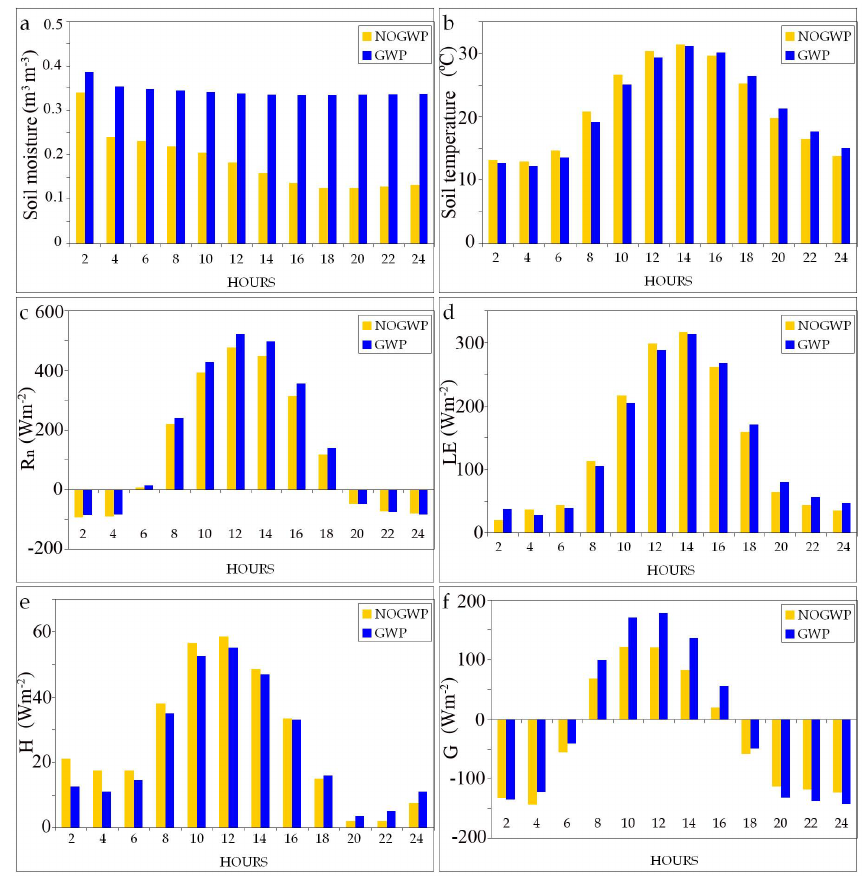
Fig. 6. The surface soil moisture, the surface soil temperature and the surface energy balance components of the two profiles on a wet summer day (19 June of the simulated